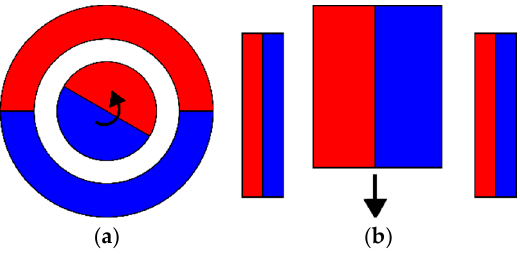
Figure 1. Conceptual drawing of ( a ) a rotational motion (torsional) magnetic spring and ( b ) linear motion (translational) and figure indicating torque and force generated due to the displacement.